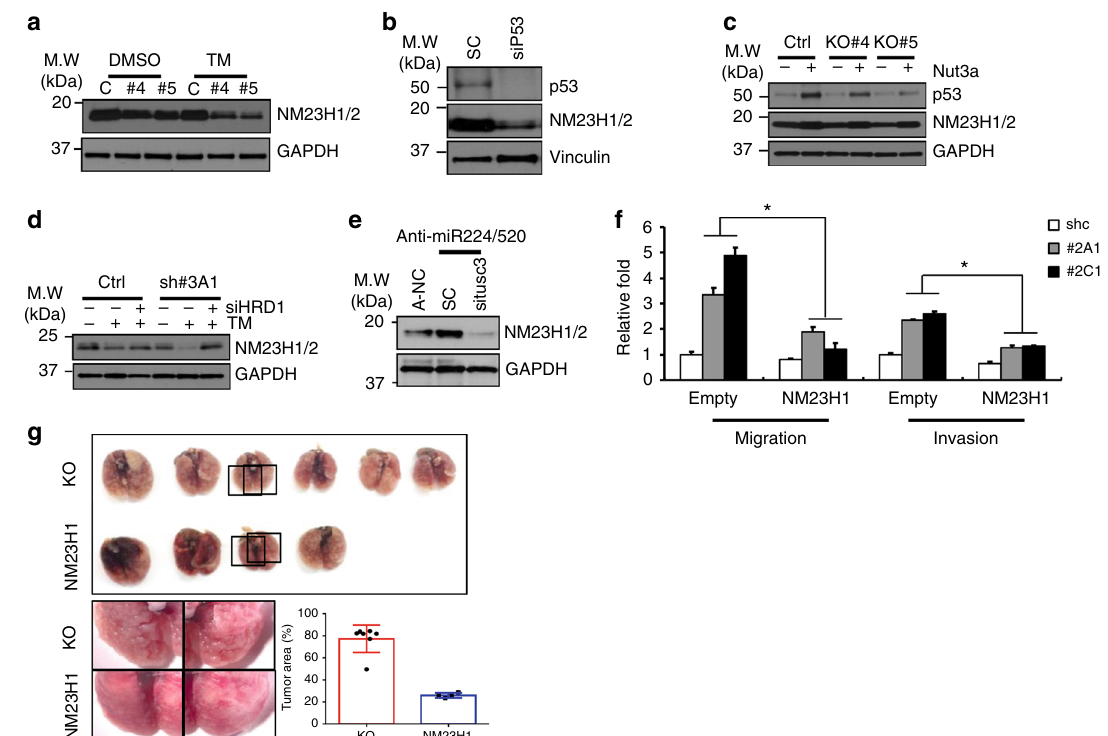
Fig. 5 Metastatic suppressor, NM23H1/2 is regulated by TUSC3 through p53 regulation. a The reduction of NM23H1/2 protein in TUSC3 KO cells in response to ER stress induction. The cells were incubated by 5.0 ug of TM for 9 h and subsequently harvested for Western blot analysis. b Decreased NM23H1 protein in p53 de fi cient cells. The H460 cells were transfected with siTP53 siRNAs for 48 h, and the expression of p53 and NM23H1/2 proteins was measured by Western blot analysis. c Restored NM23H1/2 proteins by p53 protein accumulation in A549 TUSC3 KO cells. The cells were incubated with Ntulin3a for 24 h, and Western blot analysis was performed to measure the expression of NM23H1/2. d HRD1-regulated NM23H1/2 protein in A549 TUSC3 KD cells. The A549 TUSC3 KD cells were transfected with scrambled or siHRD1 siRNAs. After 48 h, the cells were exposed to TM (5 ug/ml) for 6 h followed by Western blot analysis using indicated antibodies. e Accumulated NM23H1/2 proteins upon miR-224/-520c downregulation. The miRNA KD cells were transfected by scrambled or siTUSC3 siRNAs for 48 h, and the NM23H1/2 protein was measured by Western blot analysis. f The reduced migration and invasion of A549 TUSC3 KD cells in response to NM23H1 reconstitution. H460 TUSC3 KD cells were transfected by pCMV6-NM23H1 plasmid for 24 h. Subsequently, the cells were harvested and subject to the chambers of migration or invasion assays. Error bars indicate means± SD ( n = 3) and the p -values were calculated by two-tailed student t-test (* p < 0.03). g Restored expression of NM23H1 decreased colonization ability of H460 TUSC3KO cells. The cells overexpressing NM23H1 generated by the transduction of lent-NM23H1 virus. 1 × 10 6 of NM23H1 overexpressing TUSC3KO cells or control KO cells was intravenously injected into four NSG mice. The tumor area was obtained by Image J software by measuring the fi eld of view in lung occupied by cancer. The region for the cancer was expressed as percentage. p -value was calculated by unpaired student t -test (* p <